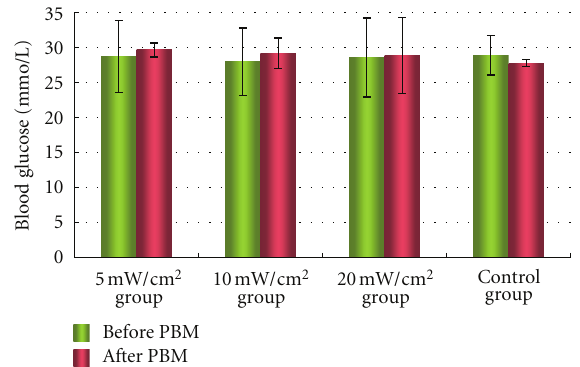
Figure 2: Percentage of wound closure throughout the experiment. Asterisk means that this group has statistical di ff erence with control group ( P < 0 . 05).